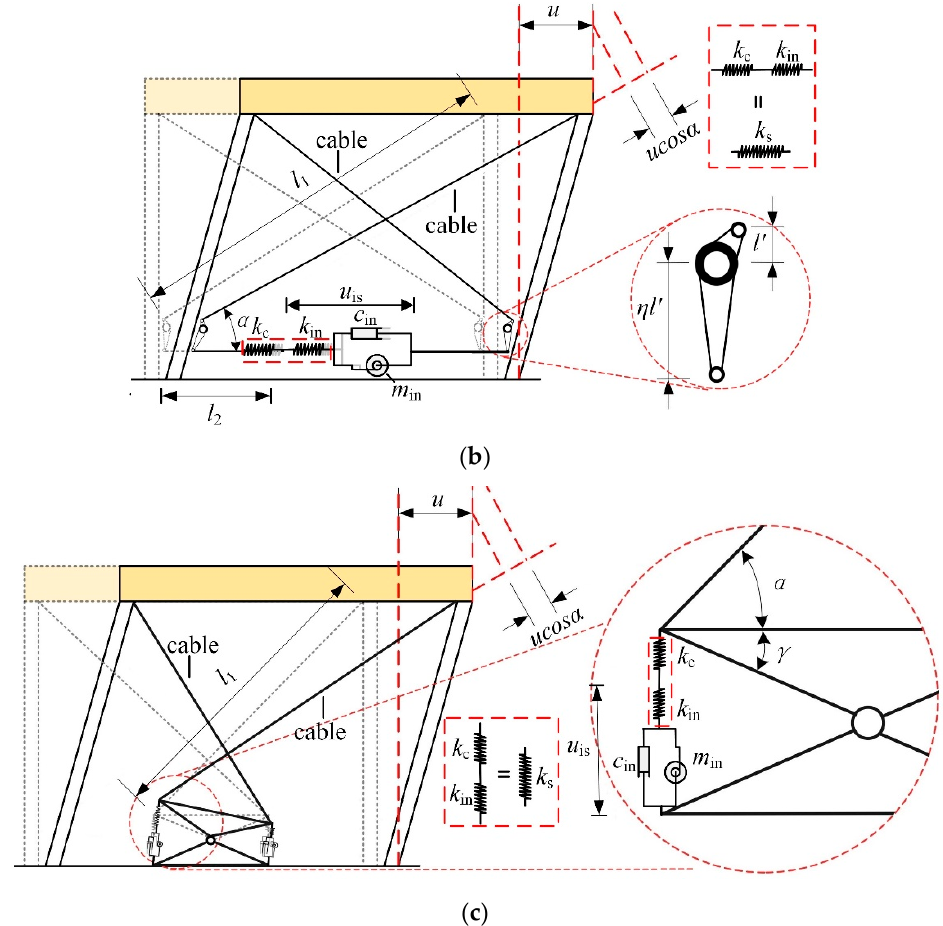
Figure 2. Schematics of different cable-bracing system: ( a ) simple cable-bracing system; ( b ) cable- Figure2. Schematicsofdi ff erentcable-bracingsystem: ( a )simplecable-bracingsystem; ( b )cable-bracing bracing lever system; ( c ) cable-bracing seesaw system. lever system; ( c ) cable-bracing seesaw